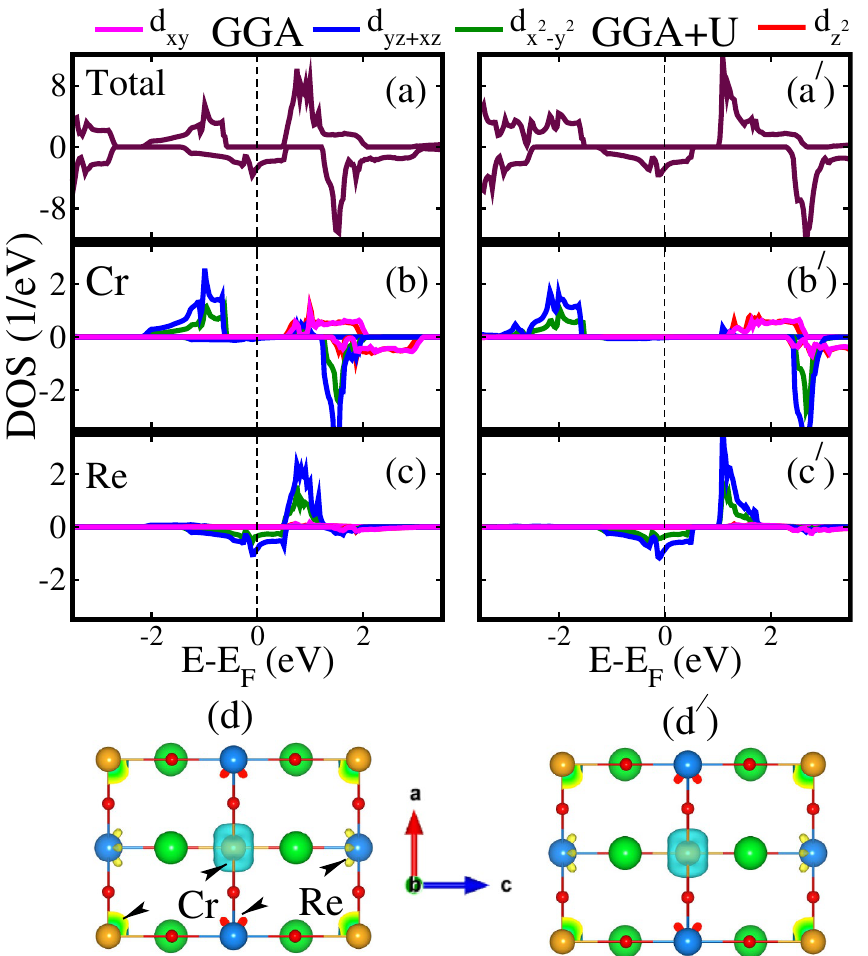
Figure 2. Calculated GGA/GGA+ U spin-polarized ( a , a ′ ) total and orbital resolved partial ( b , b ′ ) Cr 3 d and ( c , c ′ ) Re 5 d density of states (DOS) of Sr 2 CrReO 6 in a FiM spin oredering. ( d , d ′ ) represents the spin density difference (difference between spin-majority and spin-minority channels) for the top view in the ac -plane. The same iso-value of 0.05 e / Å 3 is used to produce these spin distribution plots. The Fermi level is shown by the vertical dashed line at 0 eV in each DOS figure. The x , y , and z -axes are along the crystallographic a , b , and c -directions, respectively. The y -axis ( b -direction) is pointing towards the